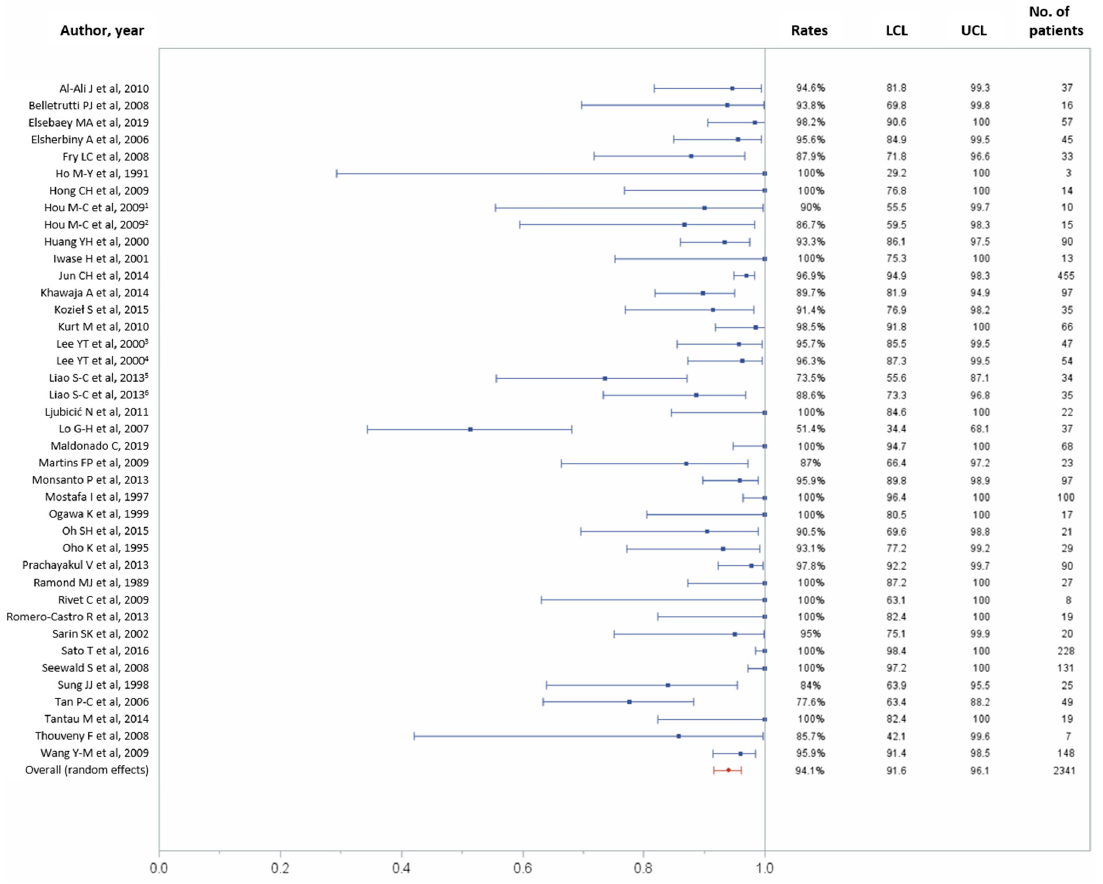
Figure 2. Forest plot of the technical success rate. Overall rate (random effects model): 94.1% (95% CI, 91.6–96.1%); heterogeneity: Q = 182.49, p < 0.0001, I² = 78.63%; UCL, upper control limit; LCL, lower control limit; No, number.